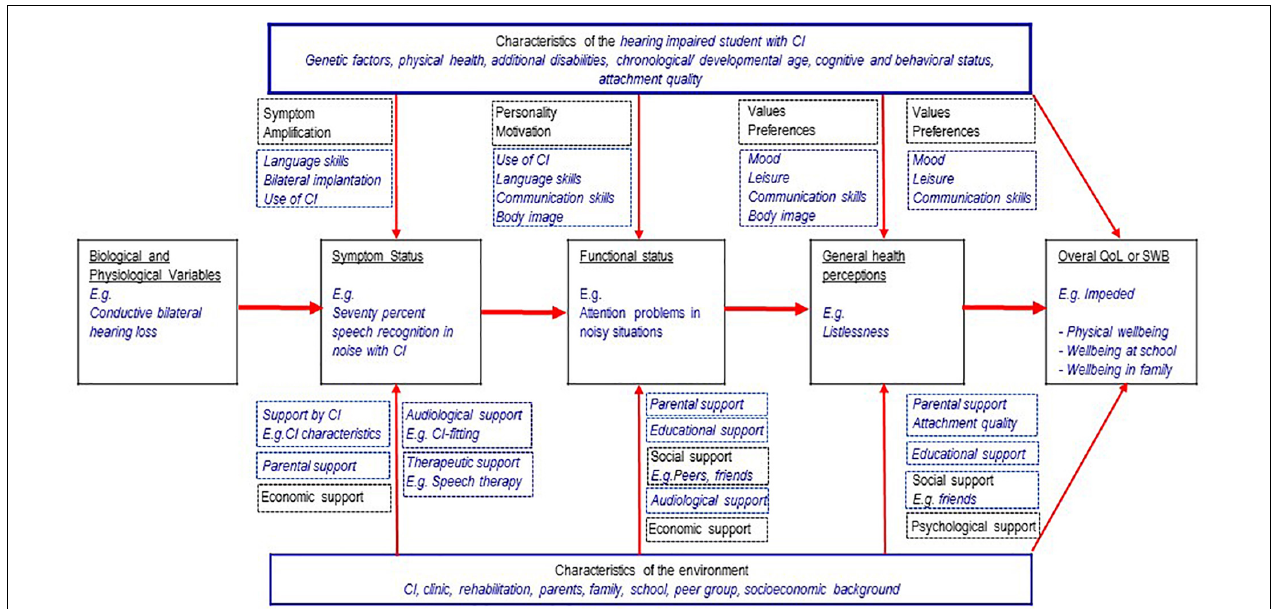
FIGURE 1 | Wilson and Cleary theoretical framework (1998, doi: 10.1371/journal.pone.0113166.g001) adapted to young CI users, with permission of the authors and the copyright holder (4/10/19, 4565201160405).